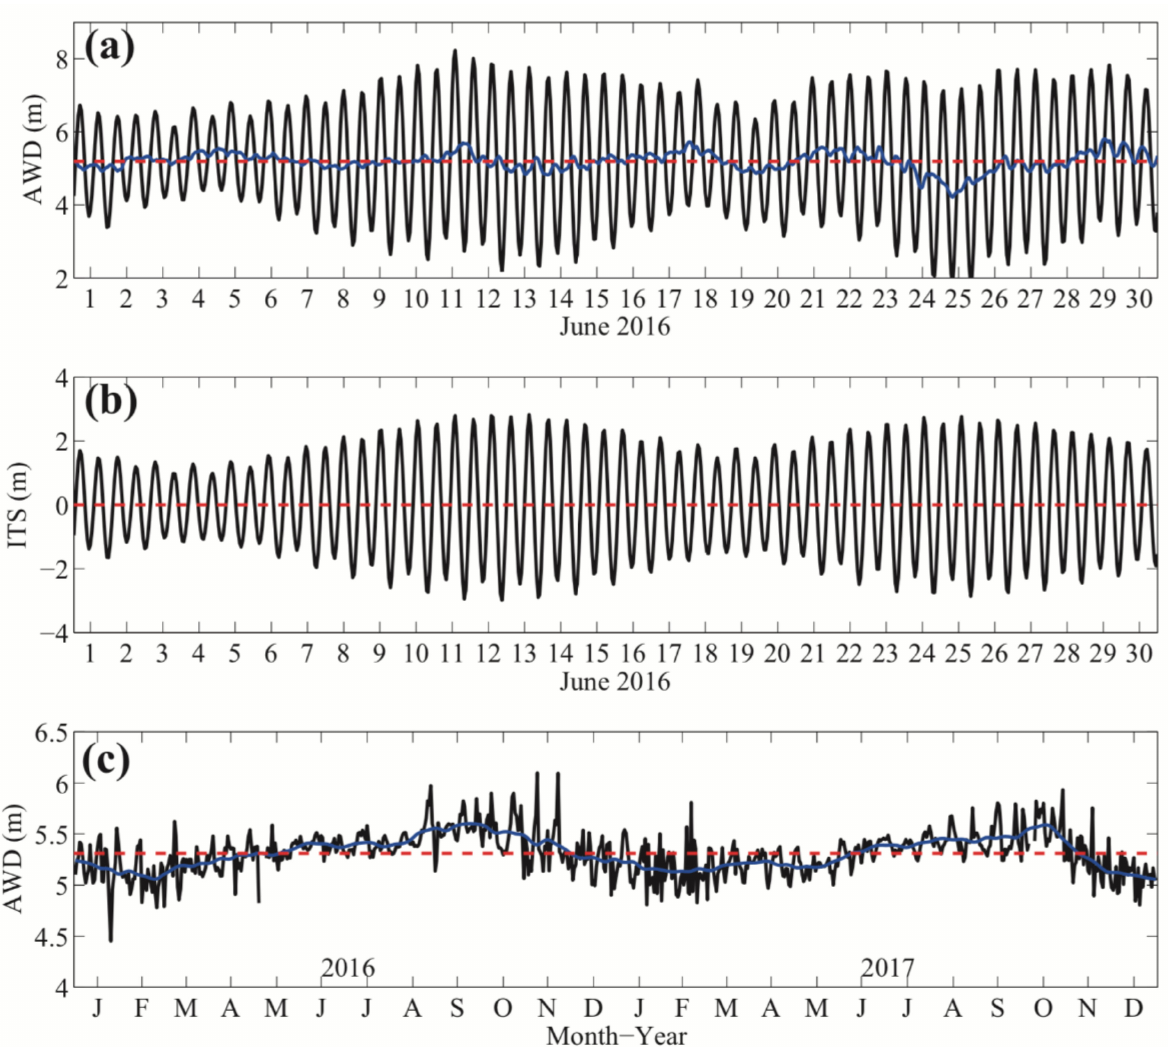
Figure 4. ( a ): The hourly water depth (WD, unit: m) at the Huo Xing Sha platform (black solid) and its mean value (red dash) in June 2016. ( b ): The integrated tidal signal (ITS, solid black, unit: m) by harmonic analysis in June 2016. The blue solid line in ( a ) represents the residual signal between the AWD and ITS. ( c ): The daily mean AWD (unit: m) from 2016 to 2017 (red curve) and the monthly mean results (dark blue). Detailed information on tidal constituents is listed in Table